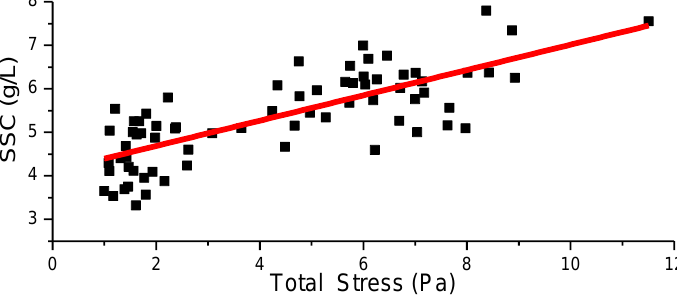
Figure 8. Suspended sediment concentration (SSC) as a function of the shear stress calculated by Equation (5) from 13 –17 December 2014 (linear fit of the total stress Pearson’s r is 0.78).